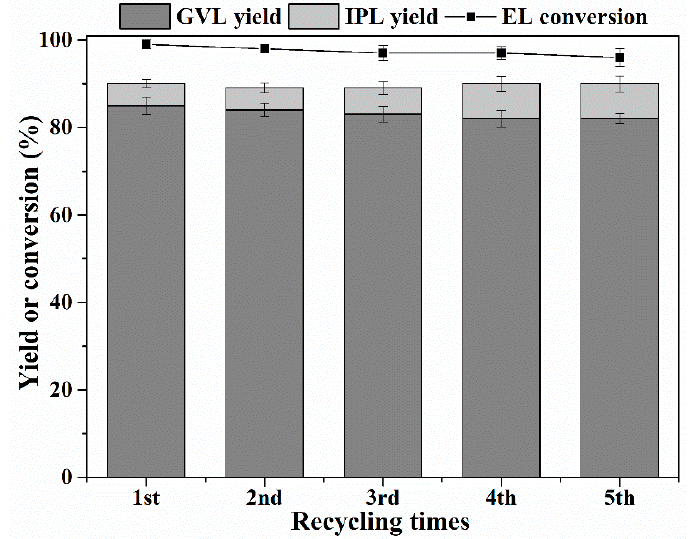
Figure 11. Reusability of PPOA–Hf-1:1.5 in the catalytic conversion of EL to GVL. Reaction conditions: EL, 1 mmol; PPOA–Hf-1:1.5, 72 mg; 2-propanol, 5 mL; T, 160 °C; and t , 6 h.